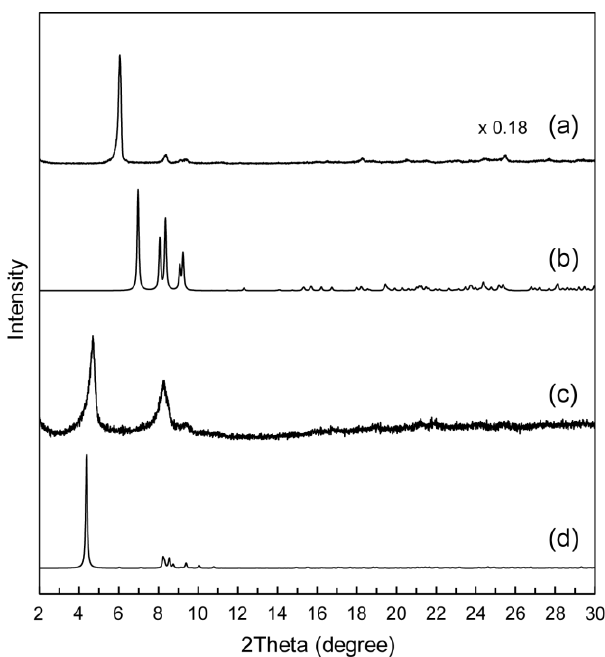
Figure 7. Powder XRD patterns of SiW 12 hybrid crystals: ( a ) as-prepared 3 ; ( b ) calculated pattern of 3 using the structure obtained by single-crystal X-ray diffraction; ( c ) as-prepared 4 ; ( d ) calculated pattern of 4 using the structure obtained by single-crystal X-ray diffraction.